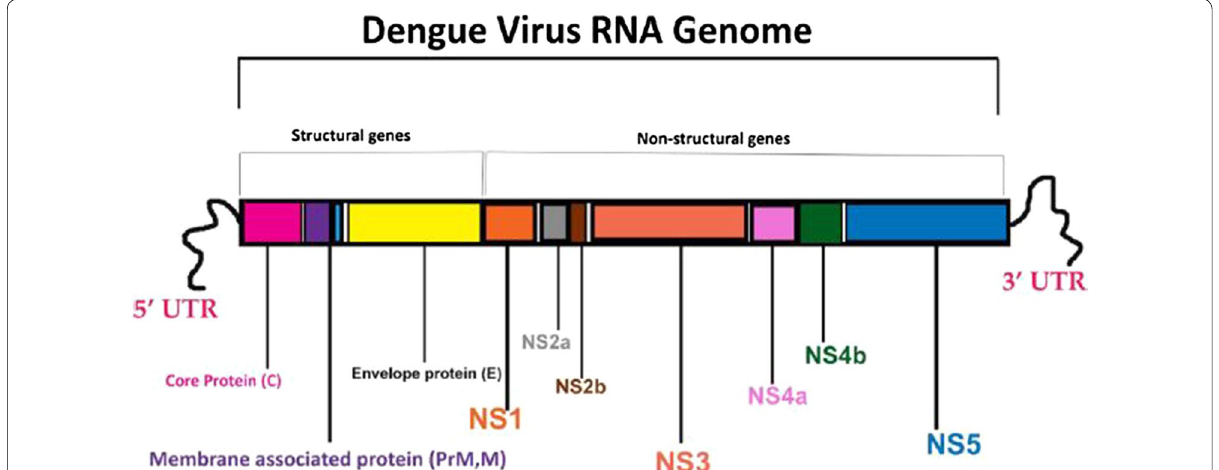
Fig. 1 RNA genome of dengue virus. Structural and non-structural genes are indicated by various colors. Three structural proteins (Core protein, Envelope protein and Membrane associated protein) at 5 ′ UTR while seven non-structural proteins i.e. NS1, NS2a, NS2b, NS3, NS4a, NS4b and NS5 at 3 ′ UTR are represented [10, 11]